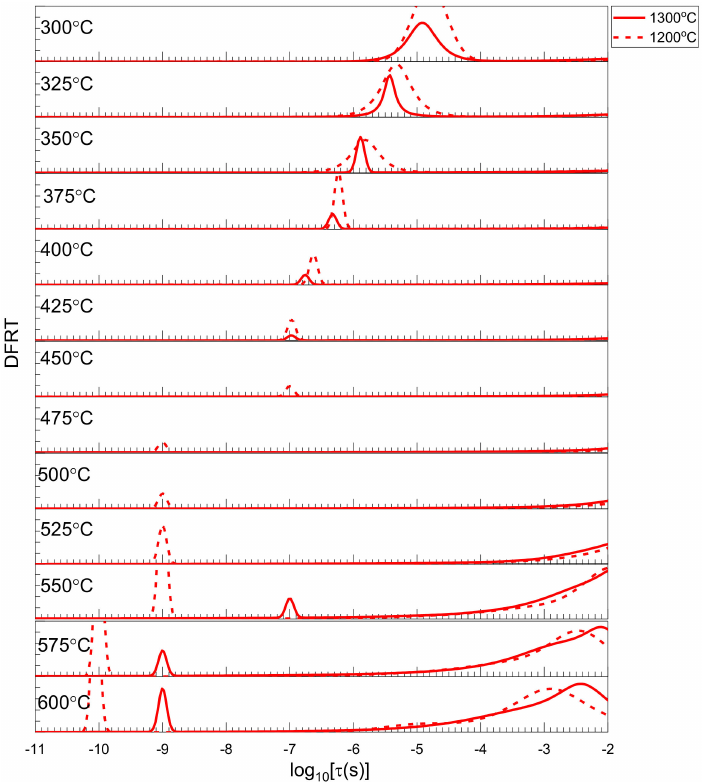
Figure 7. DFRT plots as obtained after heat treatments of the 1.0 W pellets. Some peak heights are truncated for better visualization. The peaks obtained from 525–600 ◦ C and above 1.0 MHz for both heat-treatment samples correspond to the ohmic contribution.